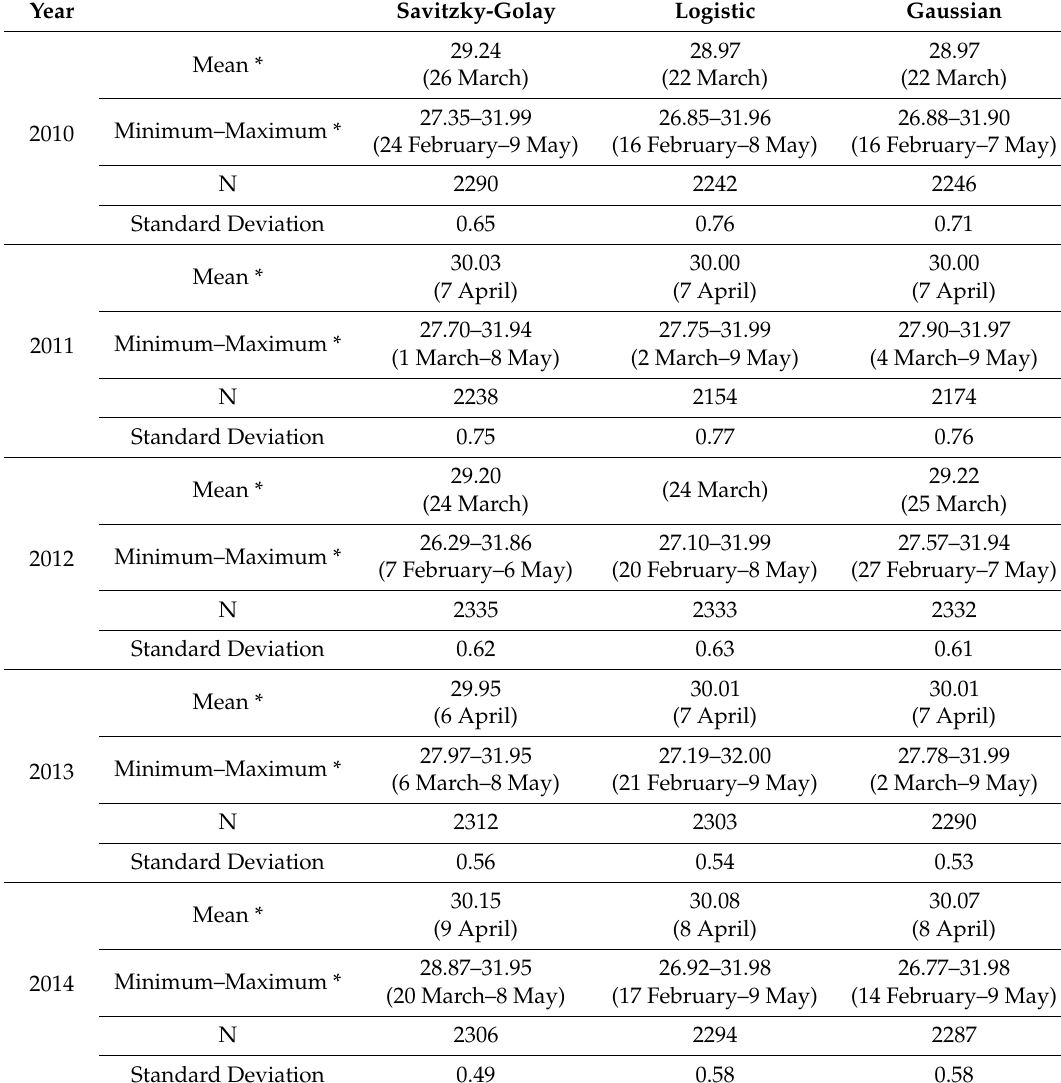
Table 2. Summary statistics for 2010–2014 start of season for the three TIMESAT